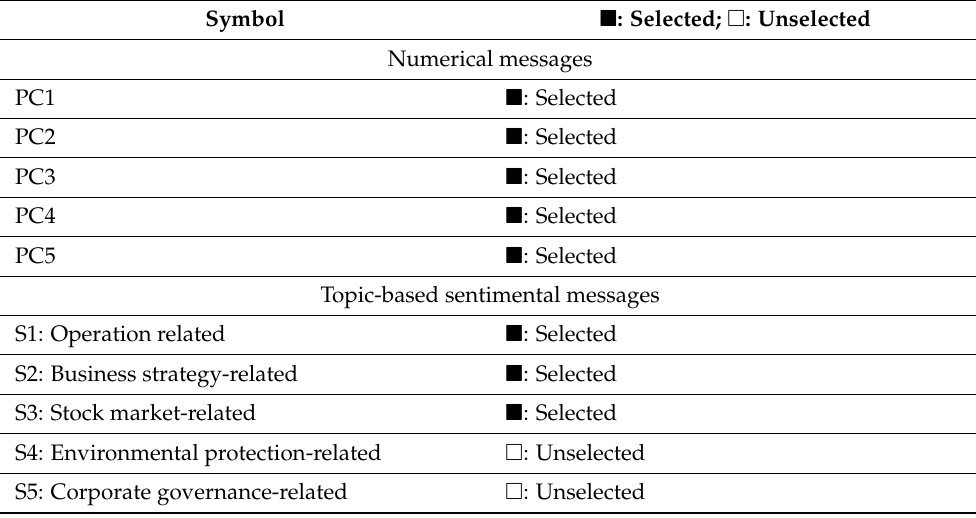
Table 7. The predictors.